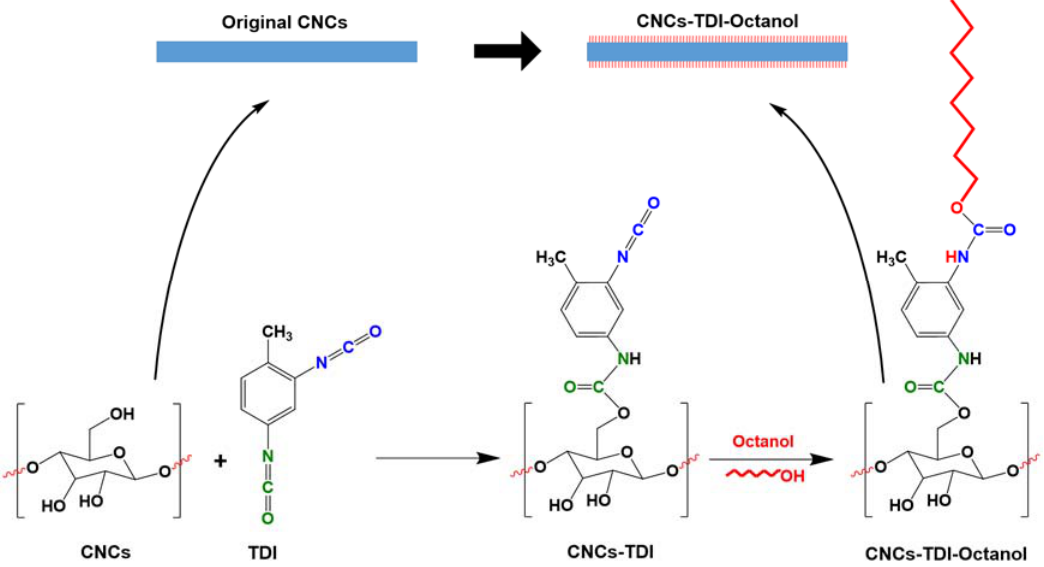
Figure 1. Tailoring the hydrophilicity of cellulose nanocrystals (CNCs) by grafting alcohols of different chain lengths on the CNC surface using toluene diisocyanate (TDI) as a linker.